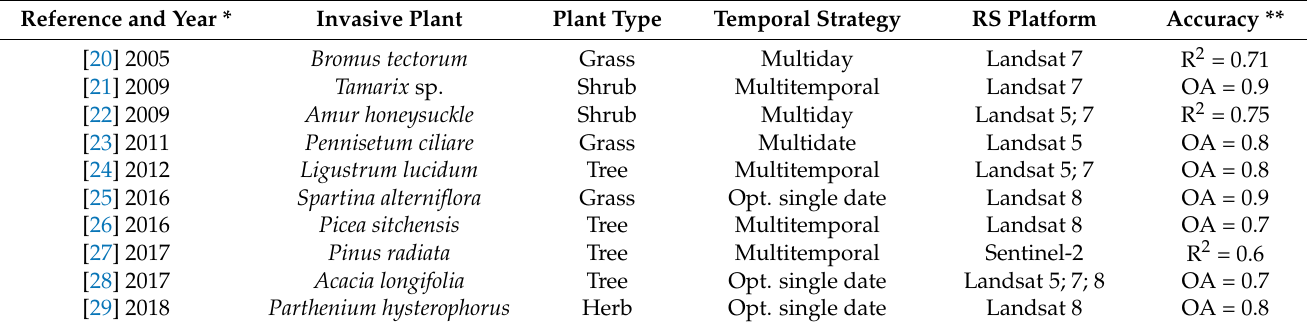
Table 1. Selection of the HR satellite-based invasive plant studies using different temporal